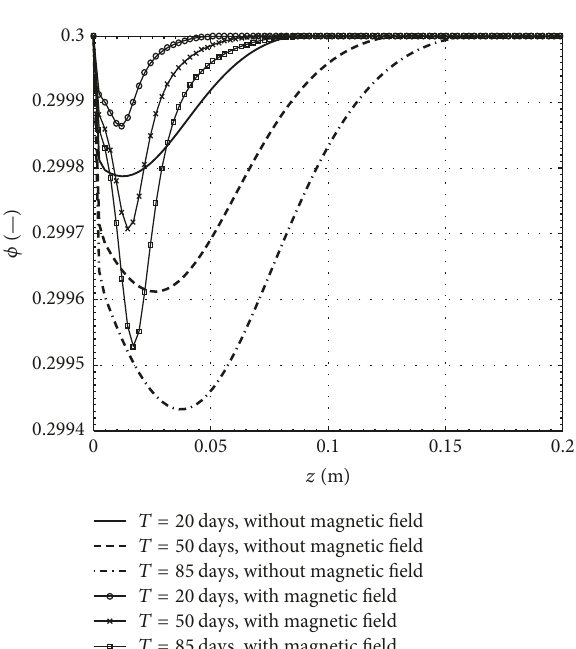
Figure 15: Porosity variation against core length with and without magnetic field effect for various values of imbibition time: magnet is placed on the left side of the